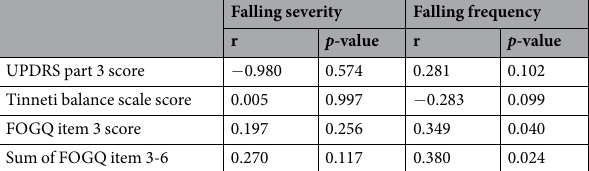
Table 3. Correlation analysis between fall variables in forward fallers, and other variables including FOG, balance, and parkinsonism, controlling for age, gender, disease duration, LED, Pisa syndrome, camptocormia, dyskinesia, wearing off, FAB and NPI scores. FOG, freezing of gait; LED, daily levodopa equivalent dose; FAB, frontal assessment battery; NPI, neuropsychiatric inventory; UPDRS, unified Parkinson’s disease rating scale; FOGQ, freezing of gait